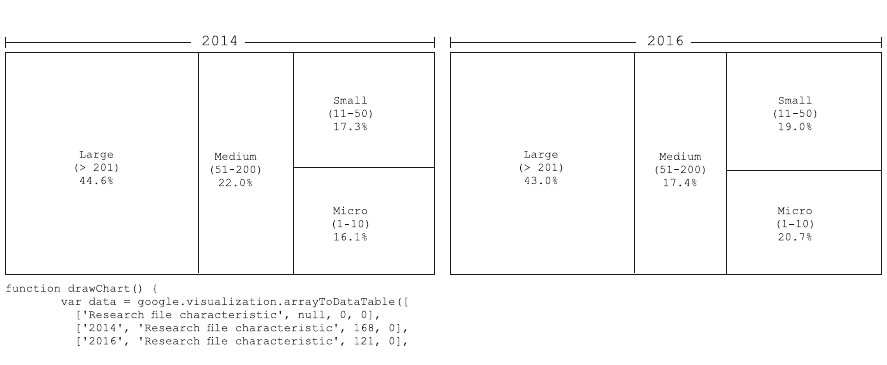
Fig. 3 – Research file characteristics - Three map chart (source: